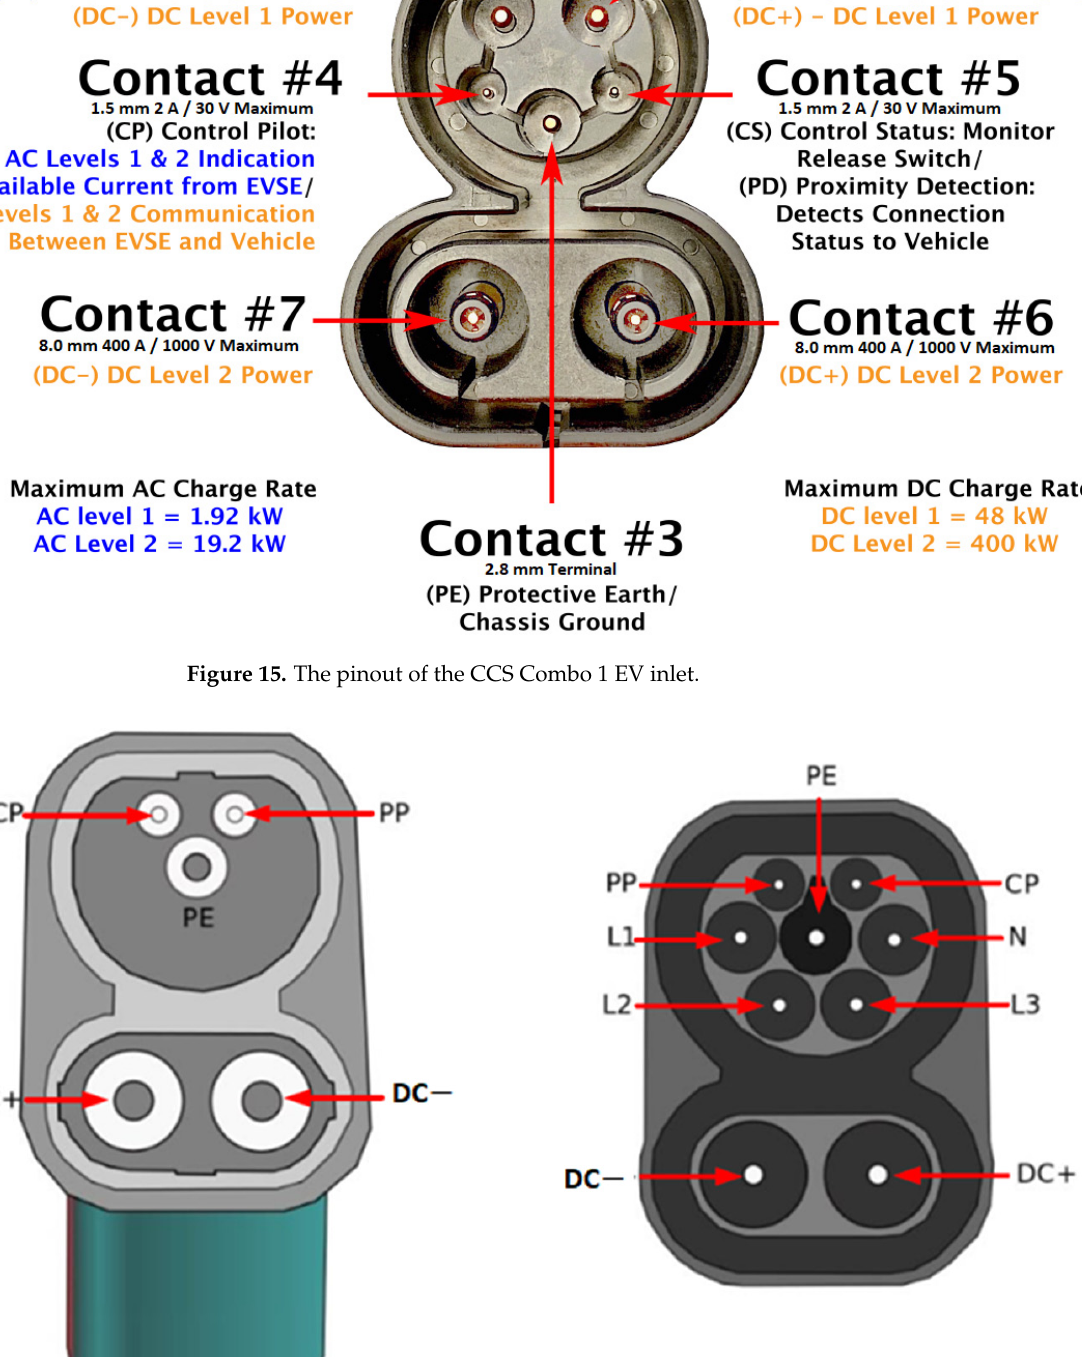
Figure 16. The pinout of the CCS Combo 2 coupler: EV Plug ( Left ) and Inlet ( Right ).